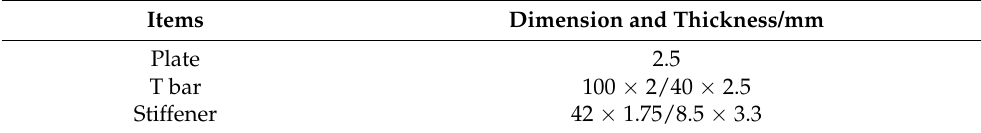
Table 2. Dimension and thickness of stiffened panel.